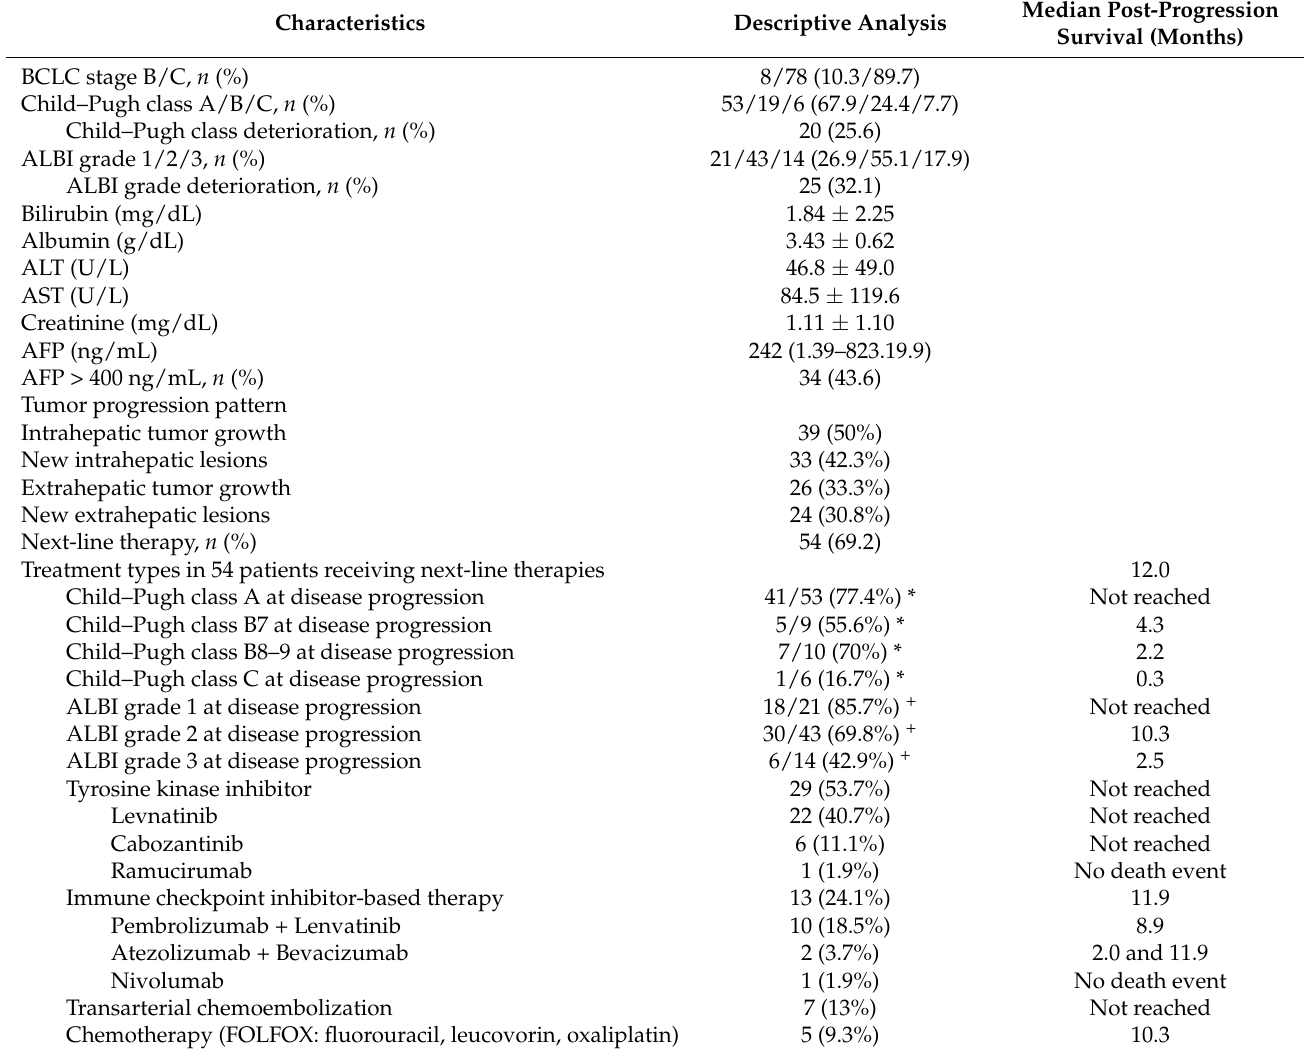
Table 4. Characteristics at disease progression in 78 patients with regorafenib